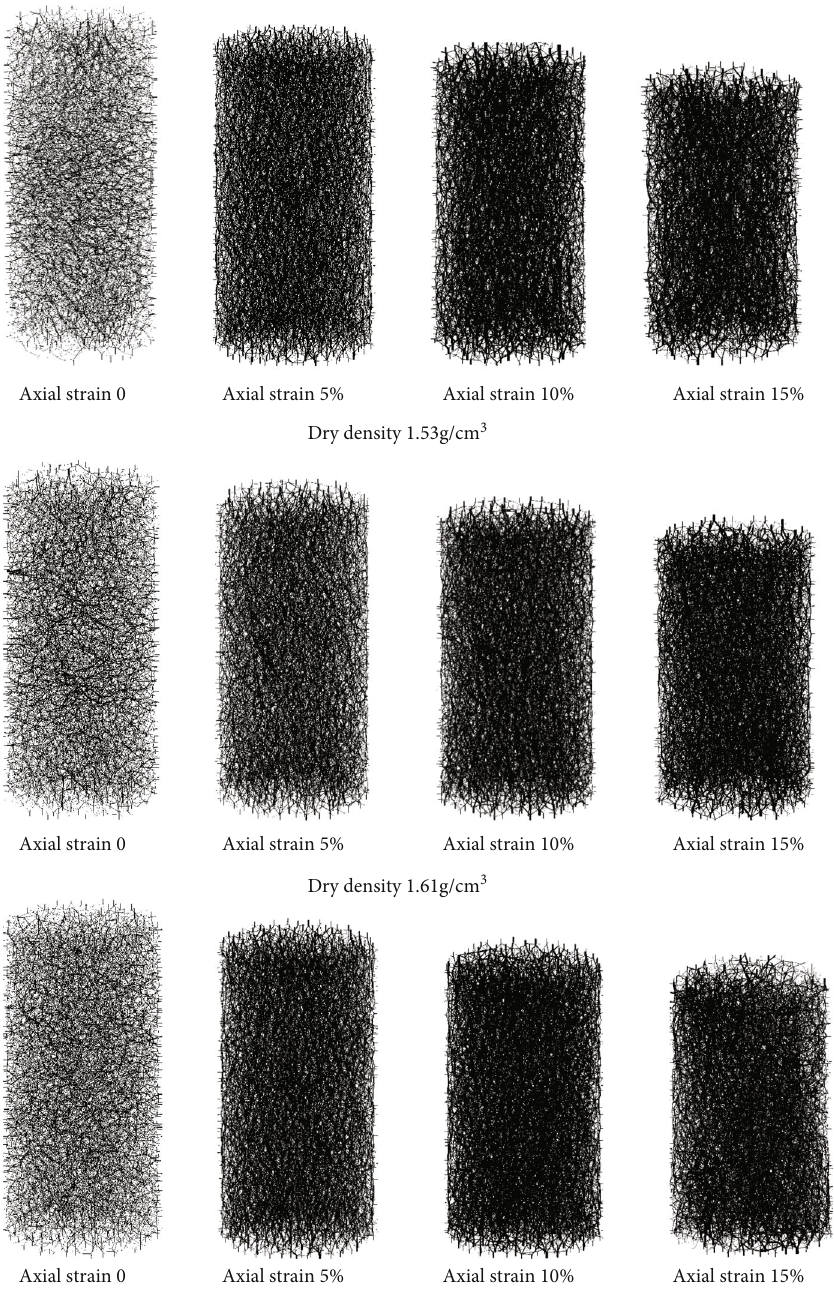
Figure 12: Contact forces between particles of axial strain samples under di ff erent dry